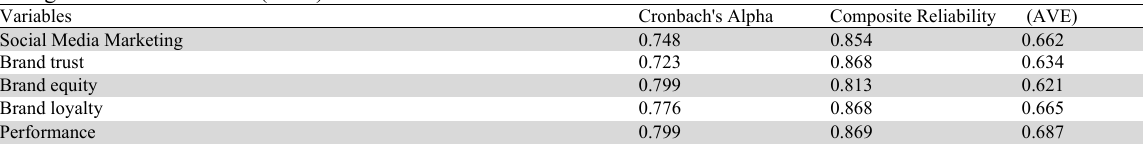
Average Variance Extracted (AVE) Variables